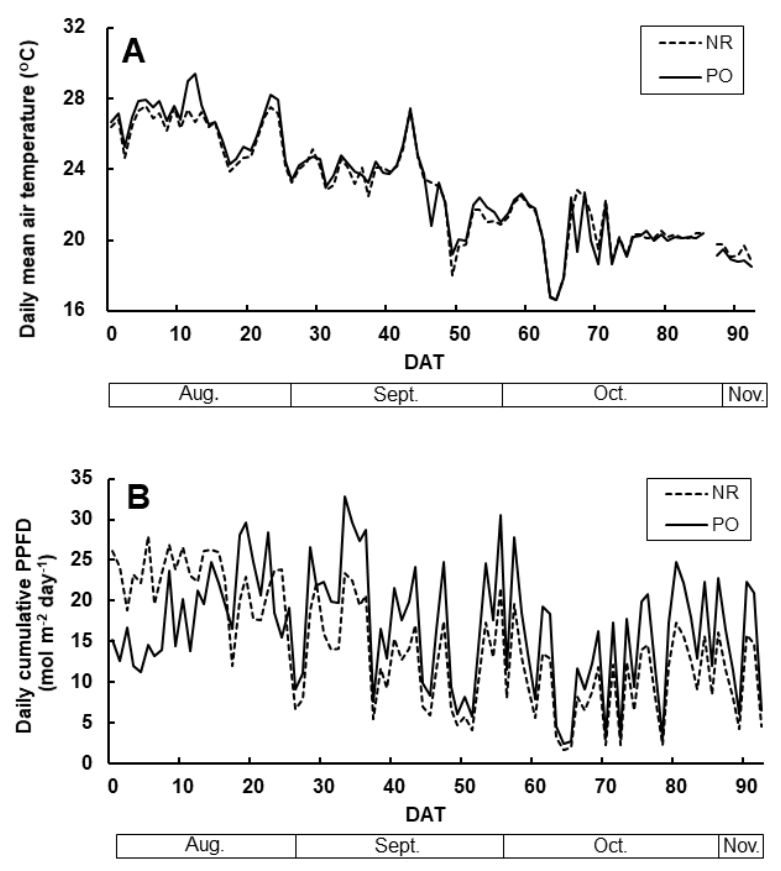
Figure 2. Daily mean air temperature ( A ) and daily cumulative PPFD ( B ) in each high tunnel. NR, NIR reflective film; PO, polyolefin film.